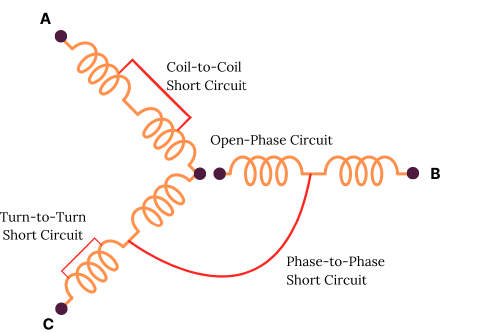
Figure 4. Common faults in the stator of a BLDC